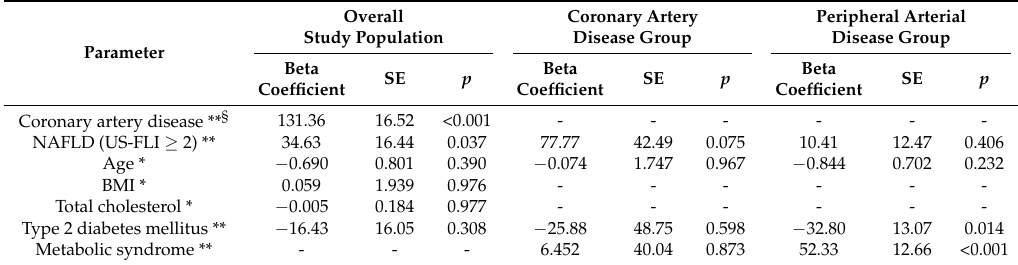
Table 4. Multivariate analysis exploring factors associated with